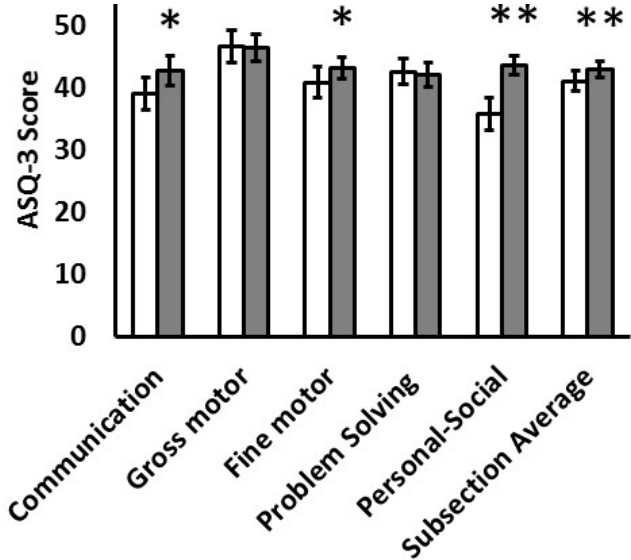
Figure 1. ASQ-3 subsection scores are contrasted for male children (white bars, N = 34) and female children (black bars, N = 32) across the 5 domains of communication, gross motor, fine motor, problem solving and personal-social development. The average score across the 5 subsections is also provided. * p < 0.05 or ** p < 0.01.